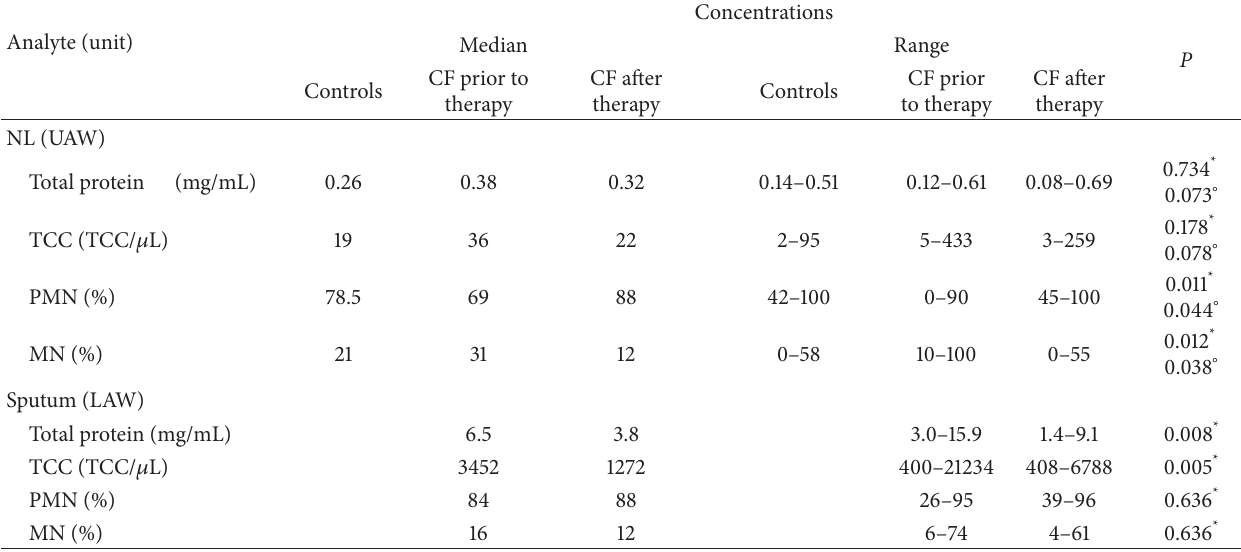
Table 4: Changes of protein concentrations and cytology before and after IV-AB treatment and comparison to findings in healthy controls. Analyte